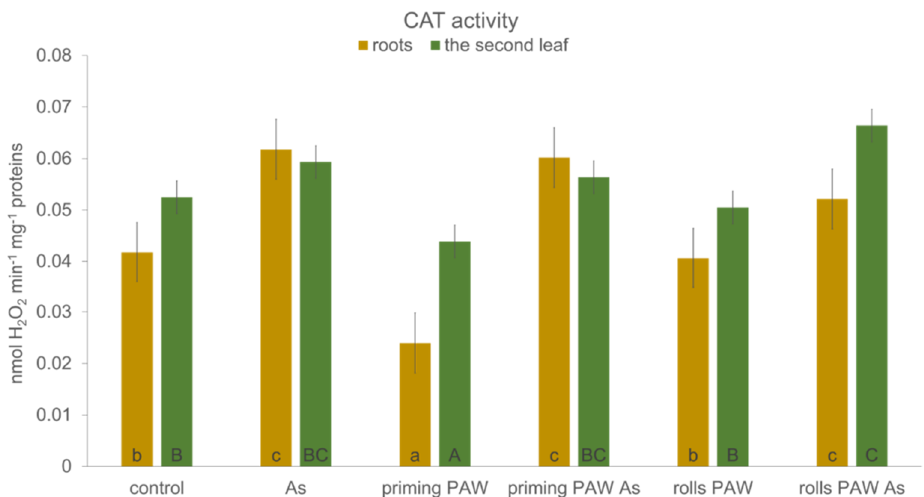
Figure 8. The catalase (CAT) activity of the maize roots and the second leaf (hybrid Bielik) after